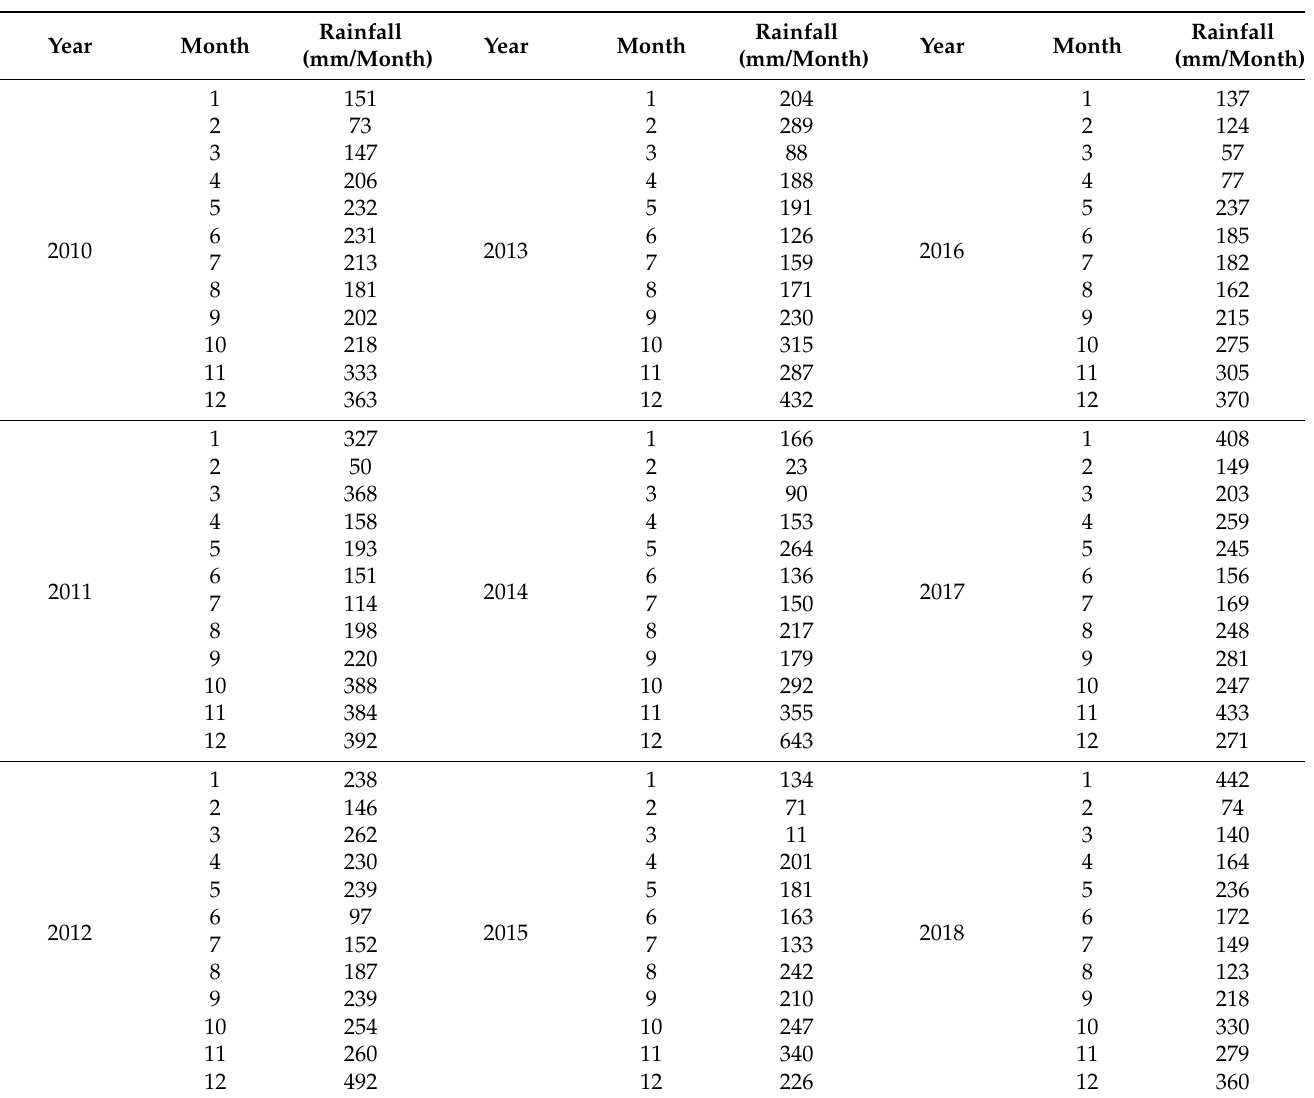
Table A2. Monthly rainfall in Peninsula Malaysia from 2010 to 2018